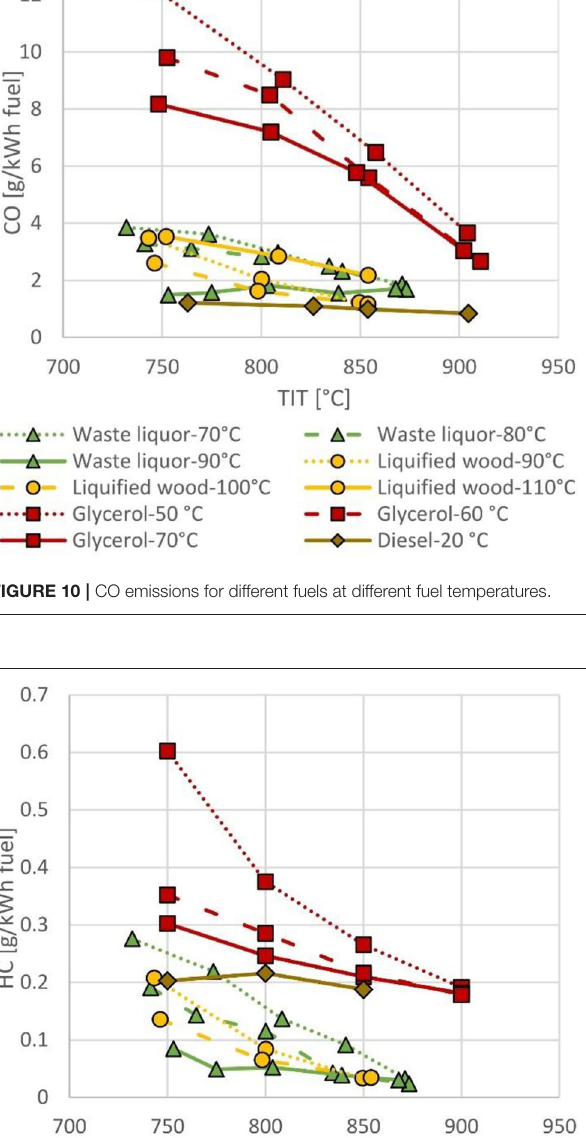
with high ignition resistance. A single-component composition combined with high boiling point (290 ◦ C) and auto-ignition temperature (370 ◦ C) of glycerol drastically alters the evaporation curve. Thus, high temperatures are required to start